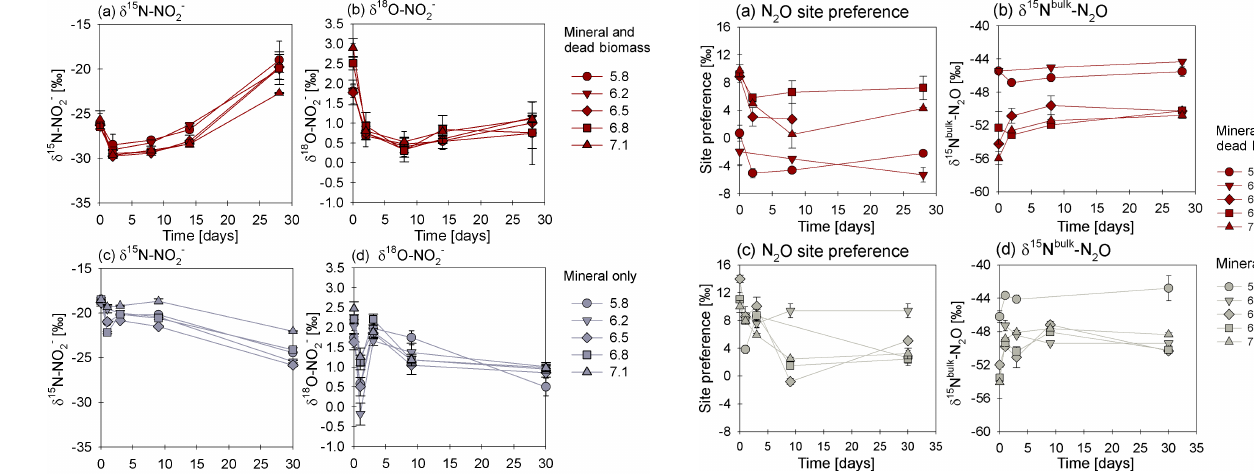
Figure 4. δ 15 N (a, c) and δ 18 O (b, d) values for NO − the mineral and dead biomass amended (red) and the mineral-only (grey) set-ups over time and at different pH levels. The standard error calculated from biological replicates ( n = 3) is represented by the error bars.